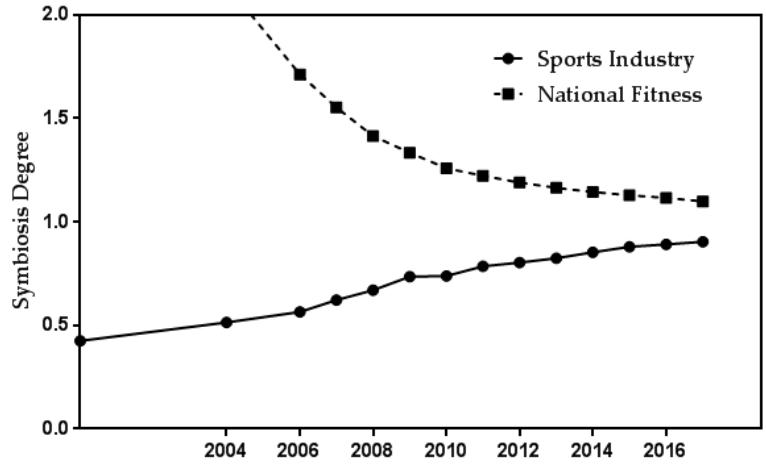
Figure 3. Time series diagram of national fitness and the sports industry symbiosis degree.